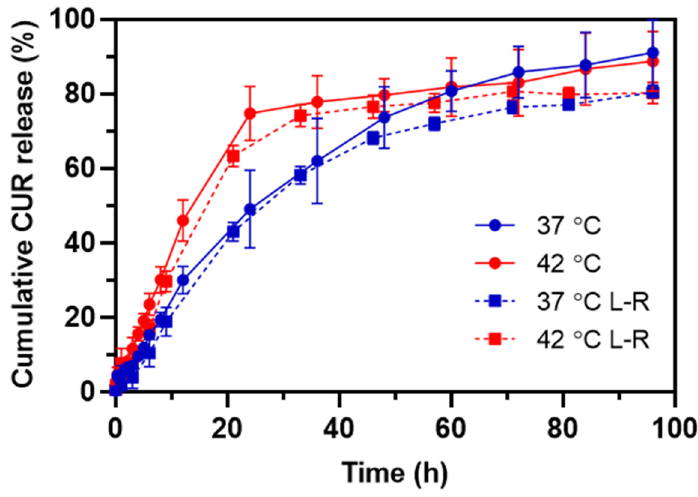
Figure 7. The release pro fi le of CUR at 37 °C and 42 °C from HA-M2005/PLL PEC-NGs (n − /n+ =